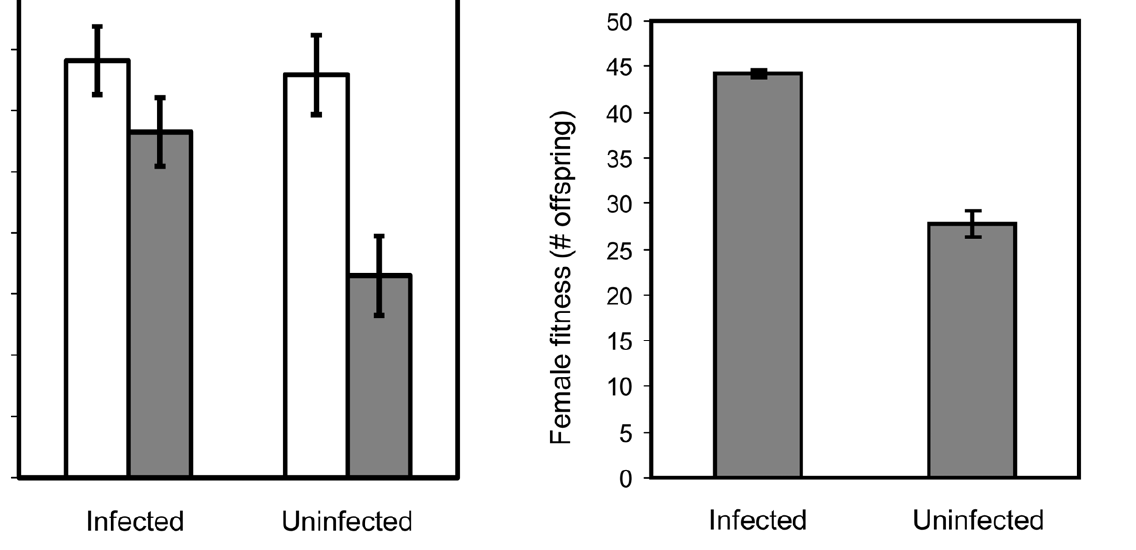
Figure 3. The cost of being cured of Wolbachia . Fitness of cured and infected females exposed to males from the base population (infected).